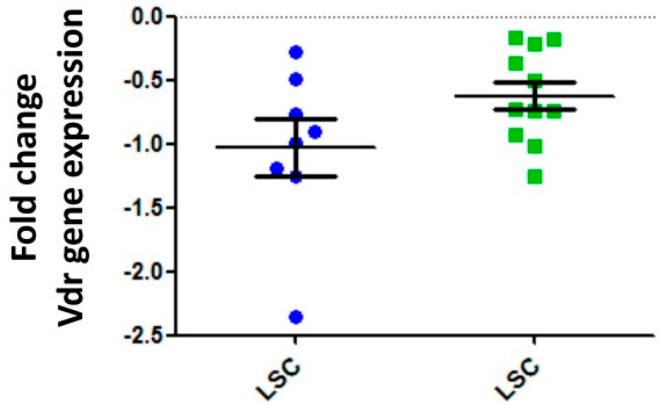
Figure 2. Leukemic stem cells (LSCs) share features with normal hematopoietic stem cells. Gene expression profiles of purified LSC populations were compared versus normal HSCs in mouse models expressing either MafB oncogene (blue dots) or Bcl6 oncogene (green dots). The same approach was used to isolate LSC and HSC (Sca1 + Lin - cells were purified). The ratios of the LSCs were referred to the control hematopoietic stem cells represented with the dotted line.